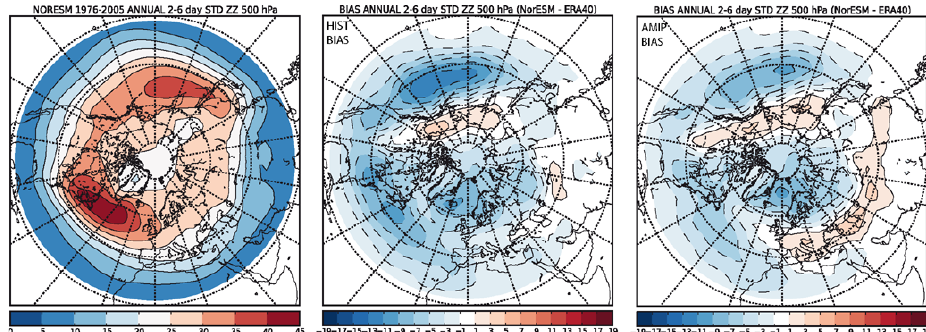
Fig. 11. Diagnosis of NH extra-tropical storminess in NorESM1-M simulations of 1976–2005 (Historic1) by applying a band-pass frequency filter, emphasising periods from 2.5 to 6days, to the 500hPa geopotential height (left). The middle panel shows bias error when compared to the ERA40 reanalysis data for 1976–2002 (Uppala et al., 2005), and the right panel shows the corresponding bias for the period 1979–2005 of the AMIP simulations with NorESM1-M run without coupling to the ocean model, but with SST-fields prescribed from observations.